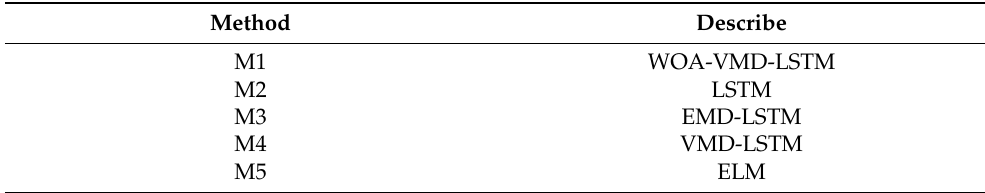
Table 3. Description of the